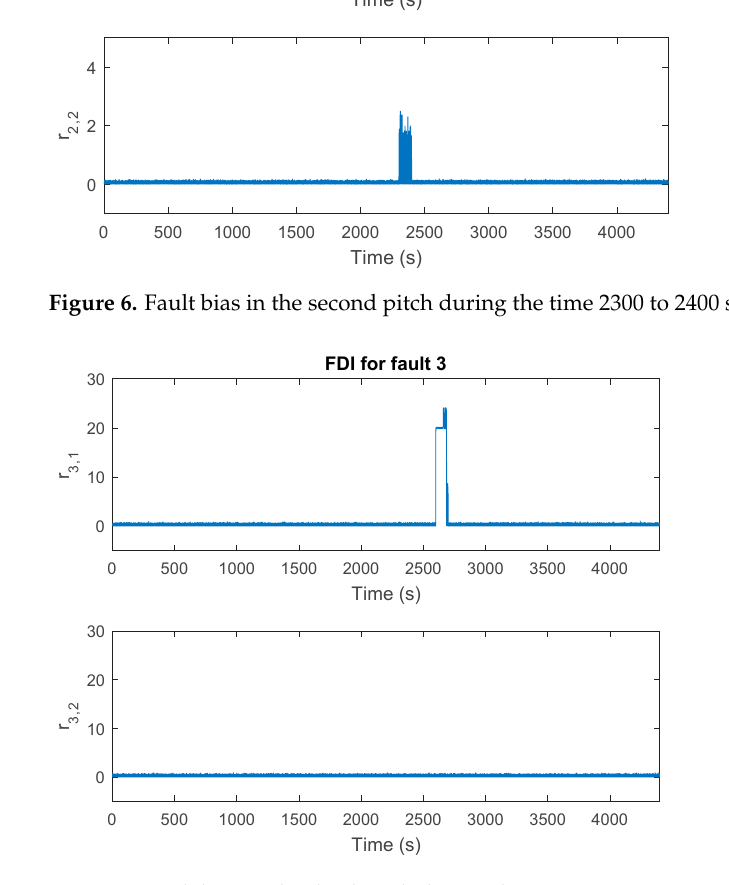
Figure 8. The abrupt fault of rotor speed sensor 1 in the time period of 1500 to 1600 s.